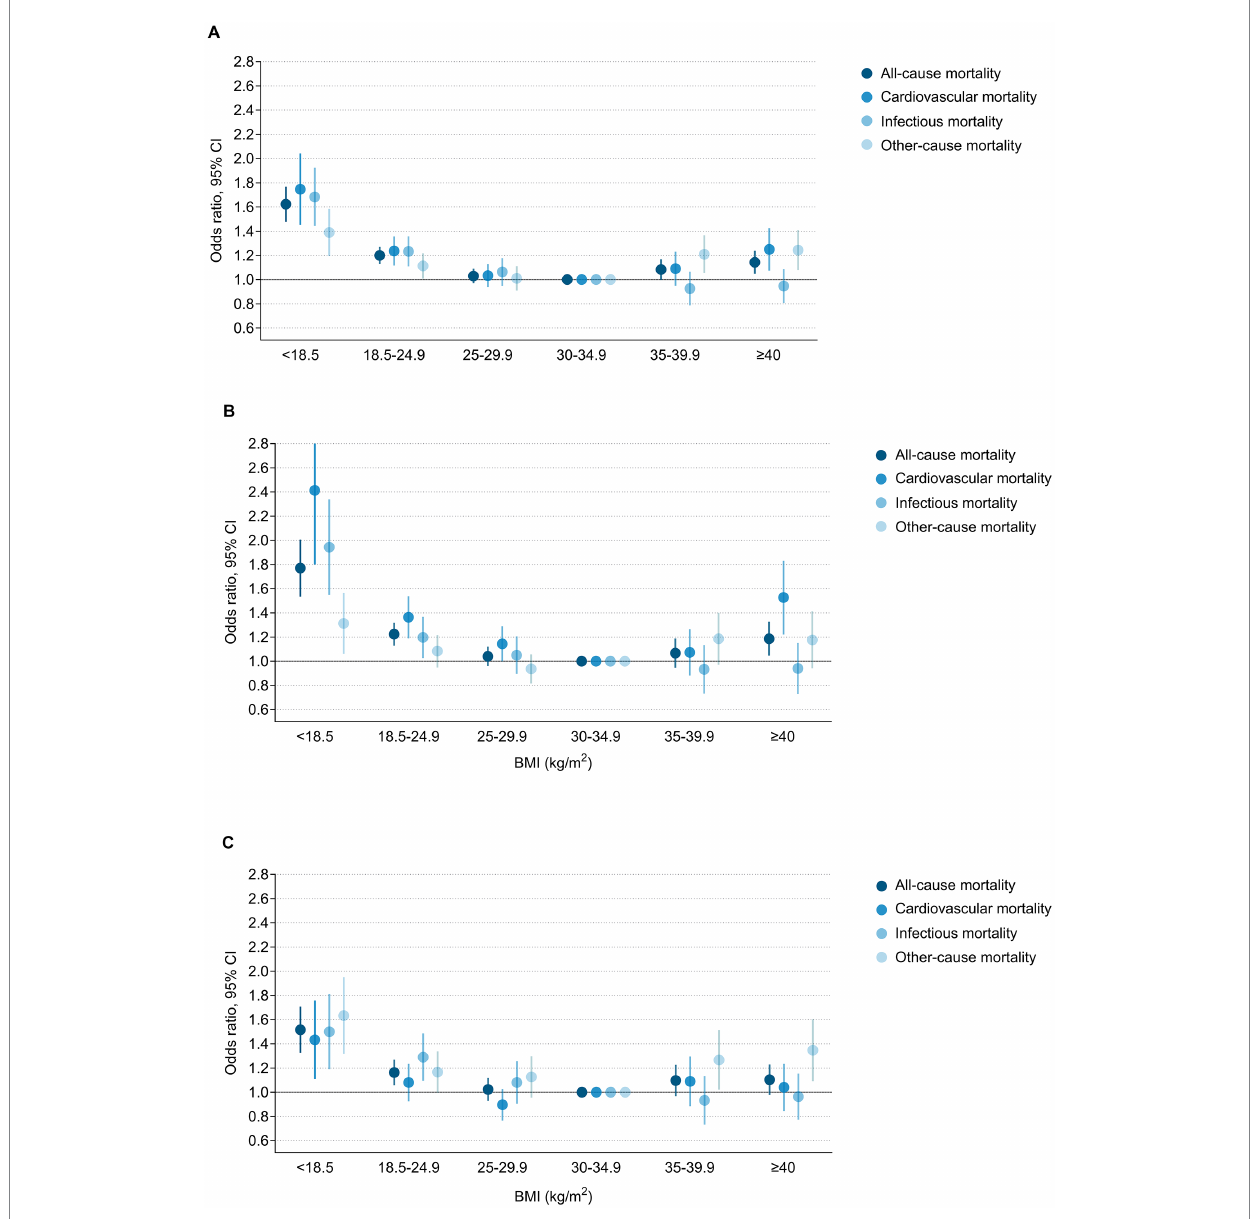
FIGURE 2 Multivariable adjusted odds ratios for all-cause and cause-specific mortality according to BMI on a categorical scale among (A) Overall population, (B) Men and (C) Women. Odds ratios and 95% confidence intervals were from multivariable adjusted logistic regression